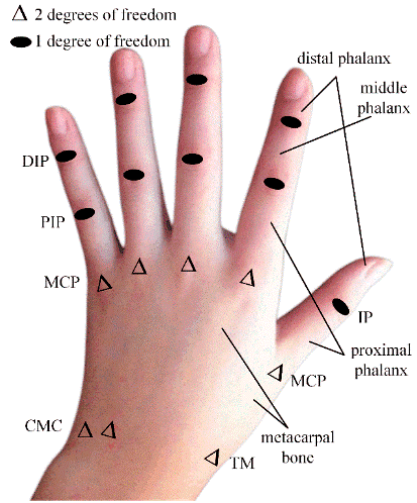
Figure 1. Structural components of the human hand.